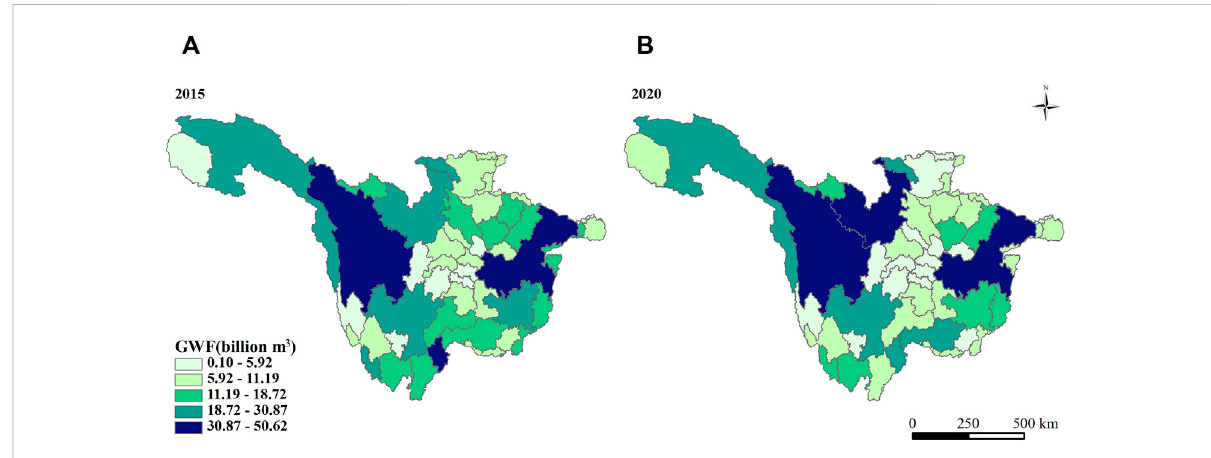
FIGURE 5 GreywaterfootprintvaluesintheupperYangtzeRiver. (A) Greywaterfootprintvaluesofprefecture-levelcitiesin2015; (B) Greywaterfootprint values of prefecture-level cities in 2020.